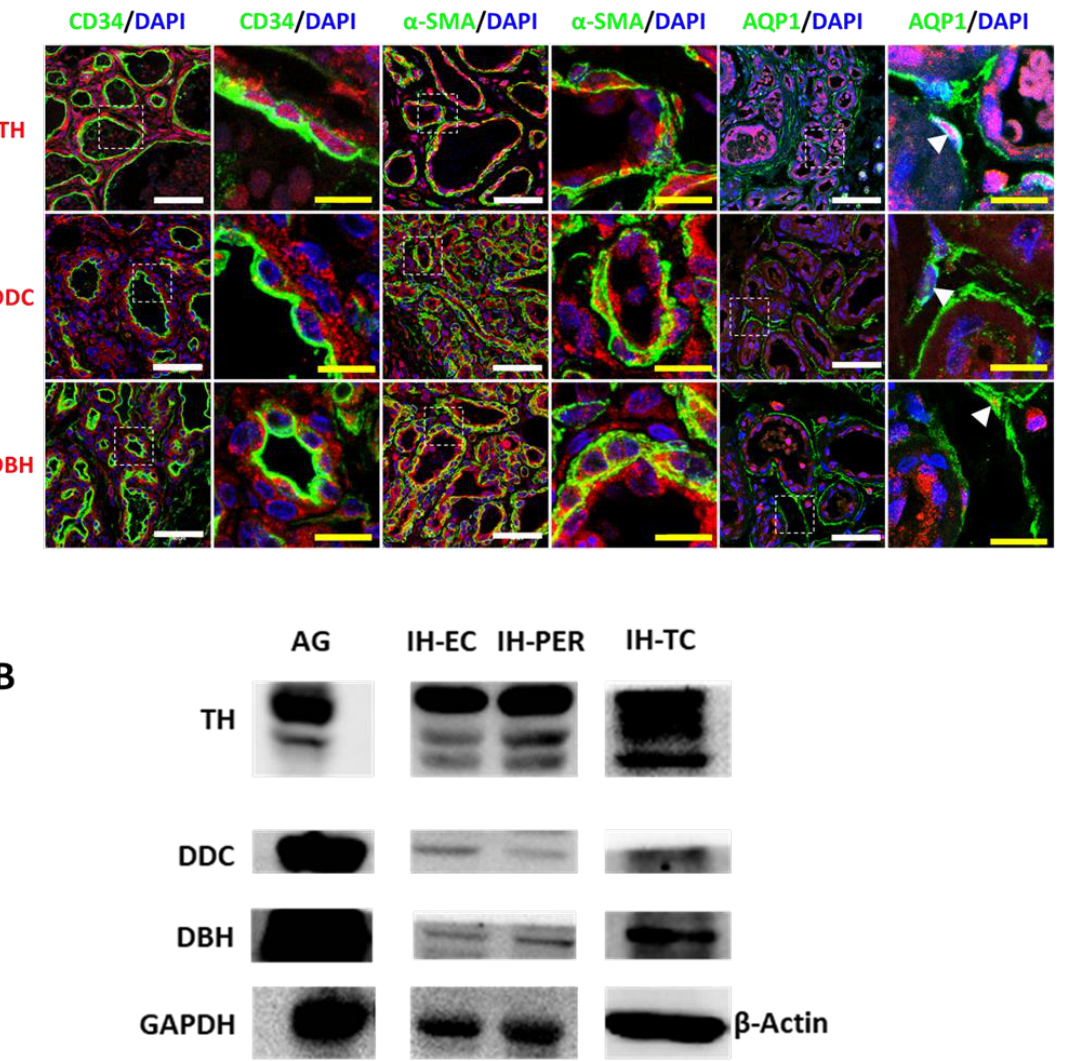
Figure 3. Catecholamine biosynthesis enzymes are expressed in IH-EC, -PER and -TC. ( A ) Immunofluorescence staining of TH, DDC and DBH in IHs. Endothelial cells are characterized by CD34-positive staining, pericytes by α-SMA and telocytes by AQP1 antibodies. Nucleus is stained with DAPI. The white scale bar size is 50 µm, and the yellow scale bar is 10 µm. ( B ) TH, DDC and DBH expression levels in the different cell types isolated from IHs were evaluated by Western blot. The adrenal gland (AG) is used as a positive control. GAPDH or β-actin are used as loading controls. IH: infantile hemangioma.